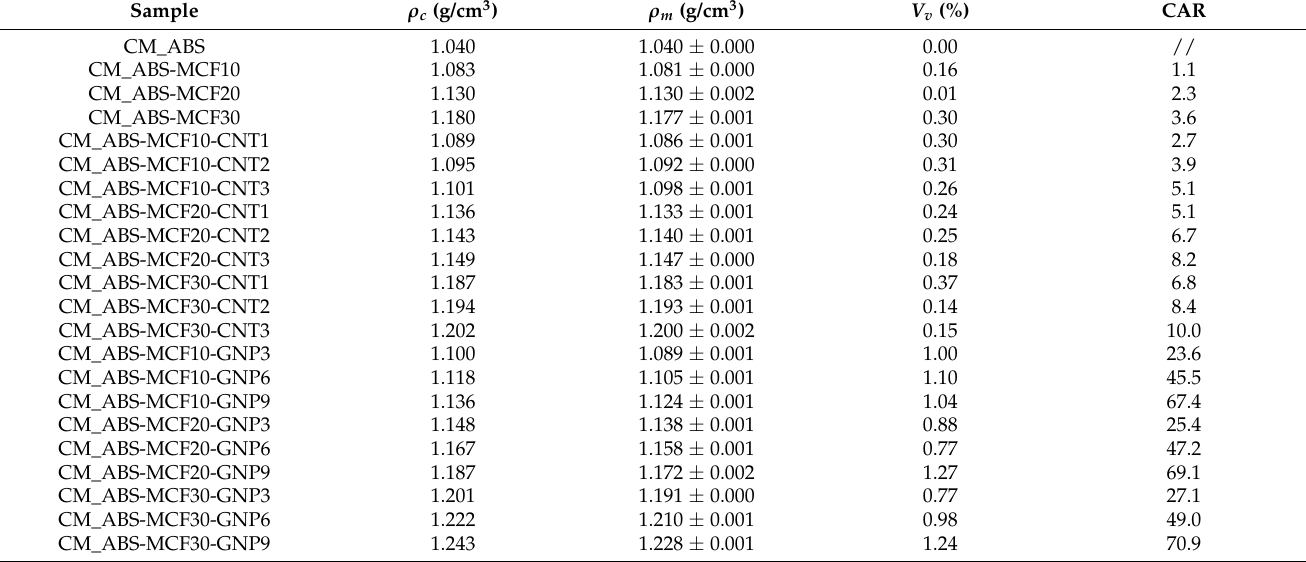
Table 4. Theoretical density ( ρ c ), experimental density ( ρ m ), and volume of void content ( V v ) of compression-molded (CM) samples. Composite aspect ratio (CAR) is also reported, as calculated according to Equation